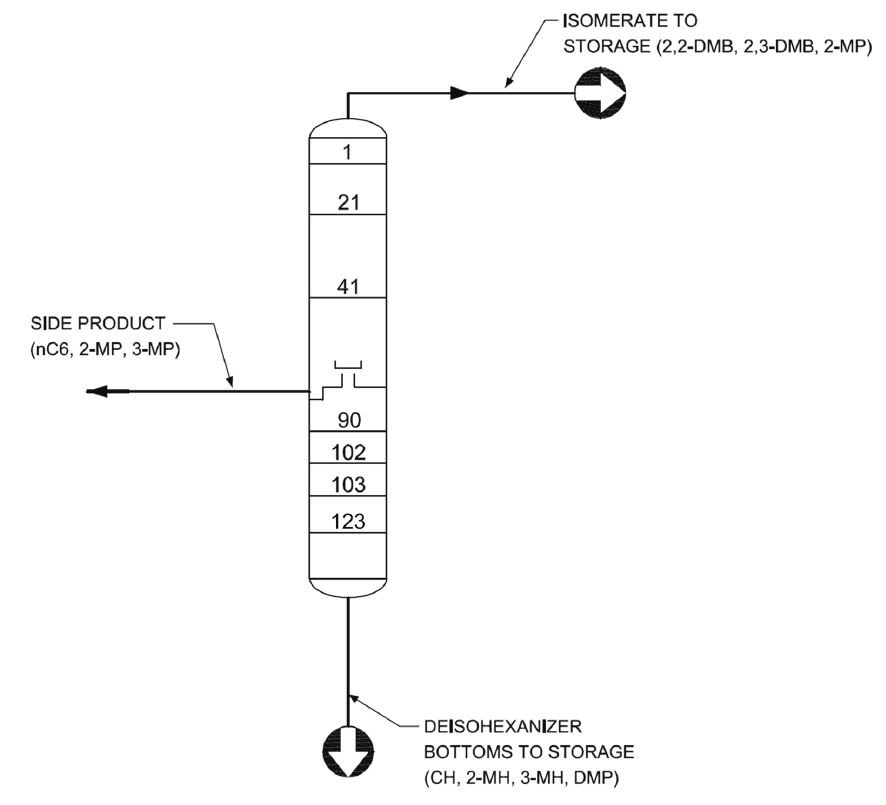
Fig. 4 – Deisohexanizer